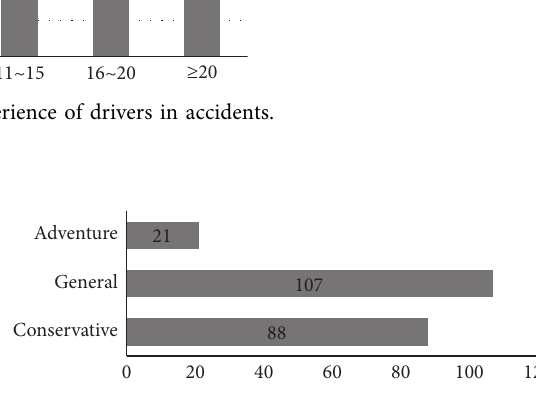
Figure 5: Distribution of driving styles of drivers in